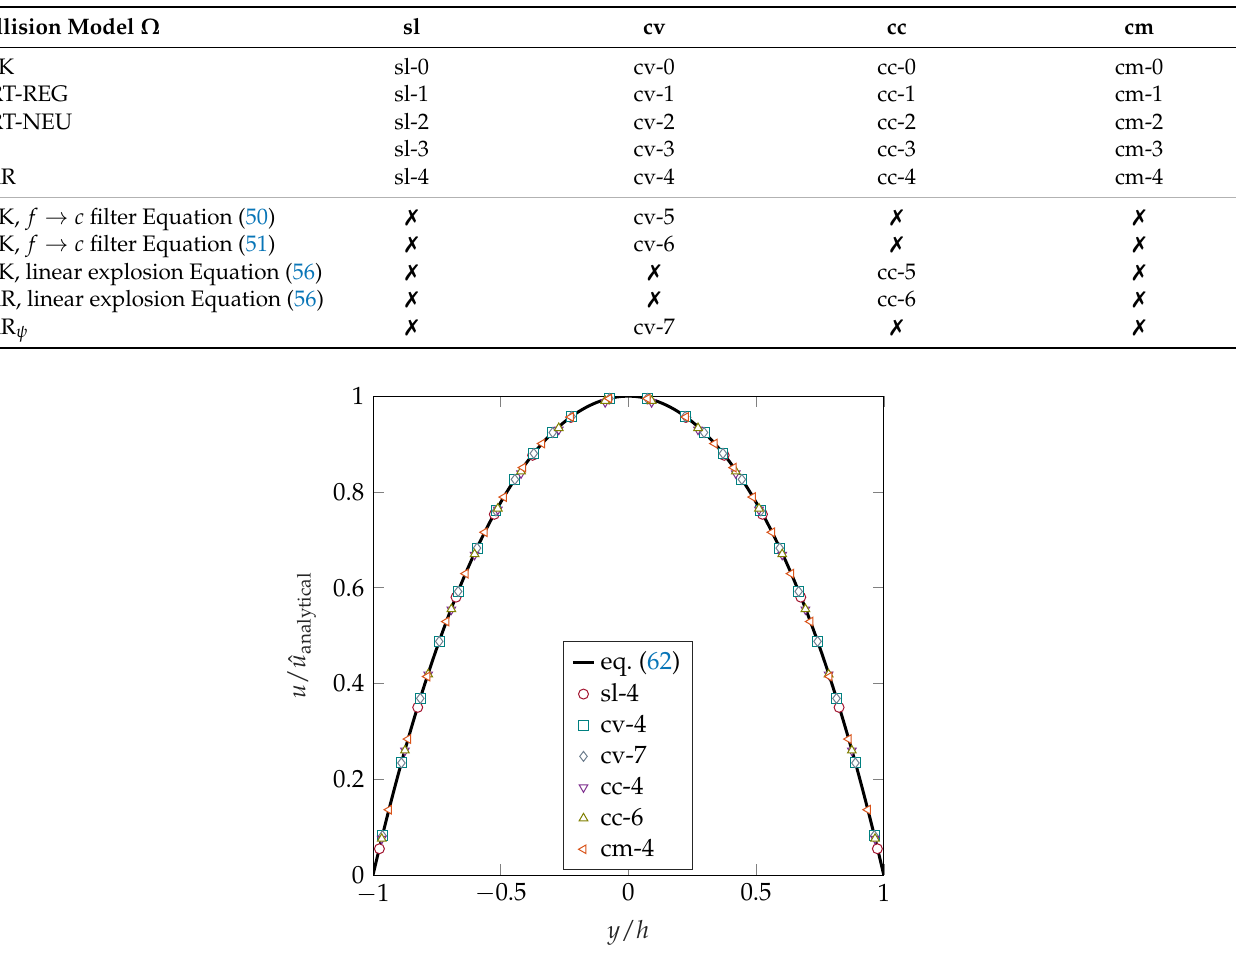
Figure 10. Normalized square duct velocity profiles for HRR models with σ = 0.98 and ˜ ω c = 1.94990 (Re h , b =